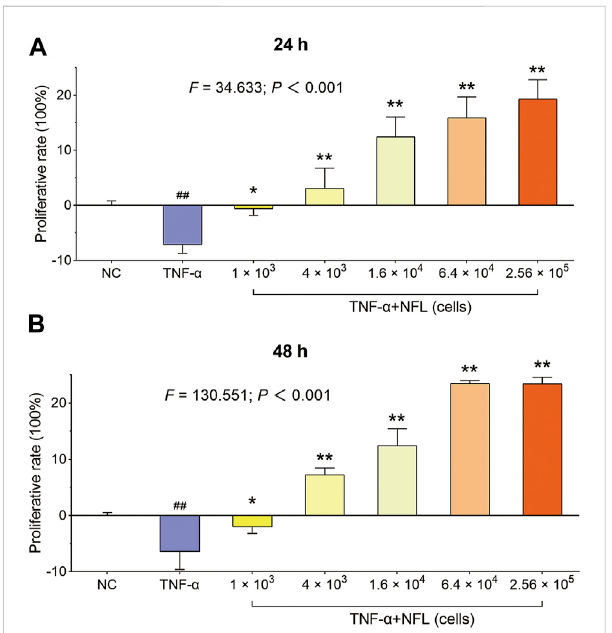
FIGURE 2 The cell viability of chondrocytes after NFL treatment. (A) Proliferative rate of chondrocytes at 24 h; (B) Proliferative rate of chondrocytes at 48 h. Values are shown as mean ± SD. ## p < 0.01 vs . NC group; * p < 0.05 or ** p < 0.01 vs . TNF- α group. Scale bar = 200 μ m.